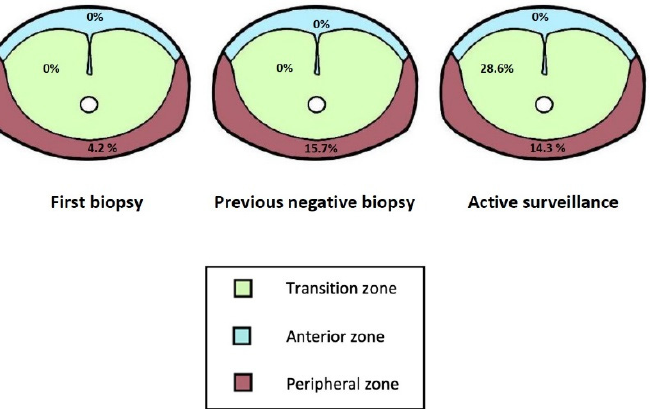
Figure 1. The additional detection rate for standard biopsy depending on both the clinical scenario and lesion location.